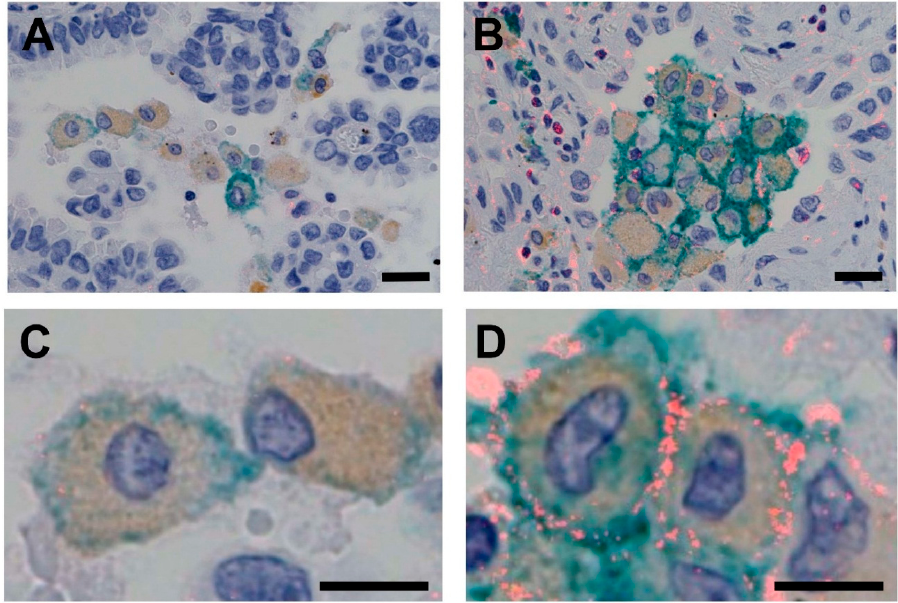
Figure 1. Triple-stained images for PID, DAB and HistoGreen. CSF1R-expressing TAMs stained positive for CSF1R (red), CD68 (brown) and CD163 (green). (1) TAMs with low expression levels of CSF1R ( A : low magnification, scale bar = 20 µm; C : high magnification, scale bar = 10 µm). (2) TAMs with high expression levels of CSF1R ( B : low magnification, scale bar = 20 µm; D : high magnification, scale bar = 10 µm). DAB, diaminobenzidine; PID, phosphor-integrated dot; TAM, tumor-associated macrophage.